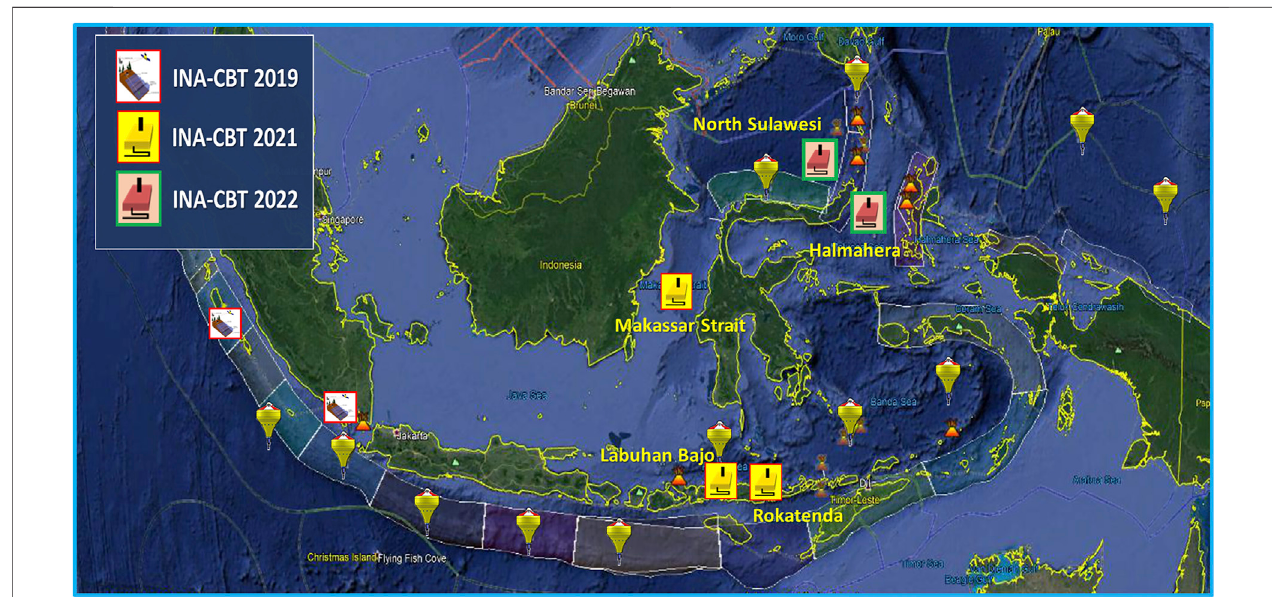
FIGURE 13 | Locations of Ina-CBT activities in Indonesia. The rectangle symbols show earlier (white), on-going (yellow), and future (beige) CBT cable systems.